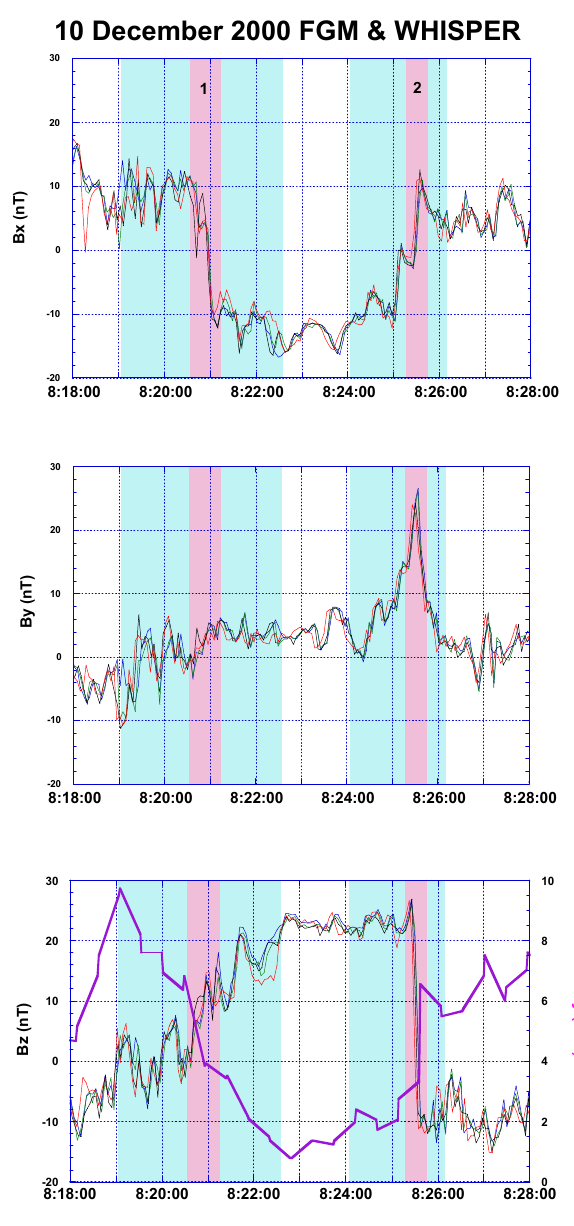
Fig. 2. Three components of the FGM magnetic field projected in the GSE frame. The time resolution is 4s. Each spacecraft is identified by the referenced colours (1, black, 2, red, 3, green, 4, blue). In the third panel, an estimate of the density deduced from the WHISPER experiment is superimposed. Blue shading corresponds to the density and magnetic field modulus variations. Pink shading corresponds to magnetic field